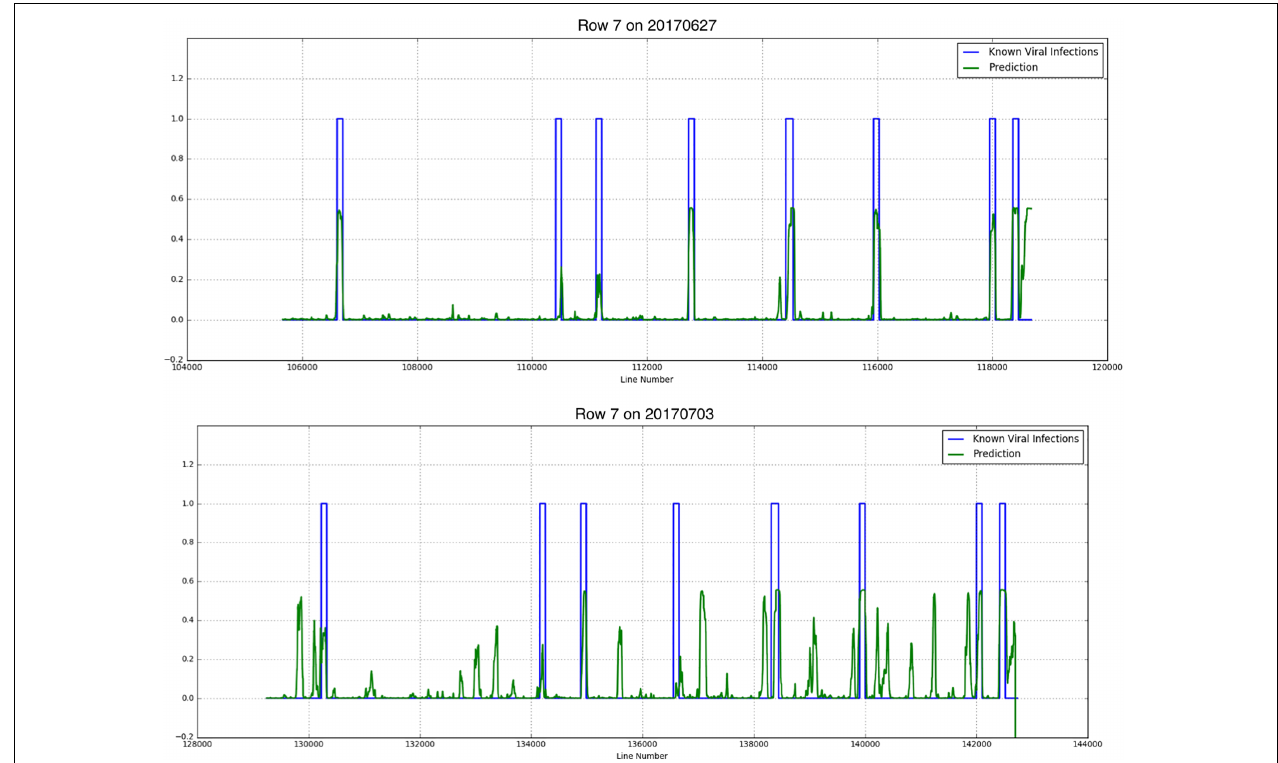
FIGURE 9 | Known PVY infection and CNN predicted infection for row 7 on 2017/06/27 and 2017/07/03.